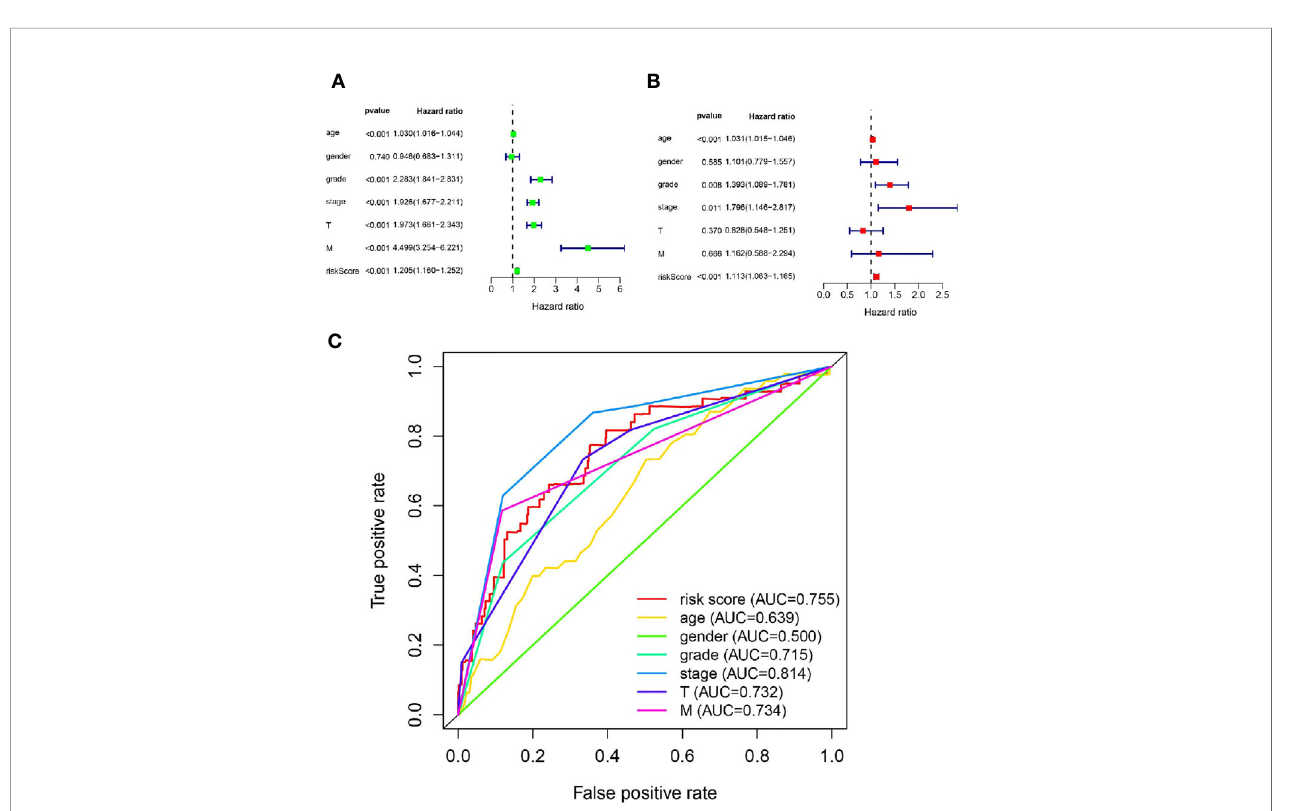
FIGURE 4 | The metastasis-related lncRNA signature was an independent factor. (A) The correlation between OS and age, gender, grade, stage, T stage, M stage, risk score was performed by Univariate Cox regression analysis. (B) The correlation between OS and age, gender, grade, stage, T stage, M stage, risk score was performed by Multivariate Cox regression analysis. (C) The AUC of the ROC curve showed the prognostic accuracy of age, gender, grade, stage, T stage, M stage and risk